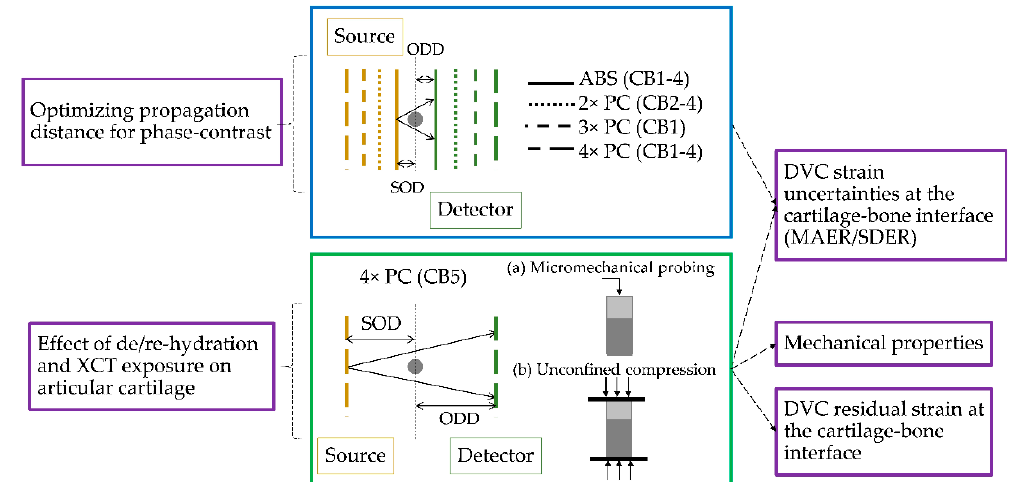
Figure 1. Schematic representation of the two testing protocols used in this study. Specimen CB1 was kept moist during XCT imaging, whereas specimens CB2 ‐ 5 were maintained fully immersed in Phosphate Buffered Saline (PBS) during image acquisition. Specimens CB1–4 (blue box) were imaged twice to allow for DVC error analysis in absorption and at increased propagation distance up to 4×. Specimen CB5 (green box) was instead imaged only in phase ‐ contrast (4×) twice for DVC error